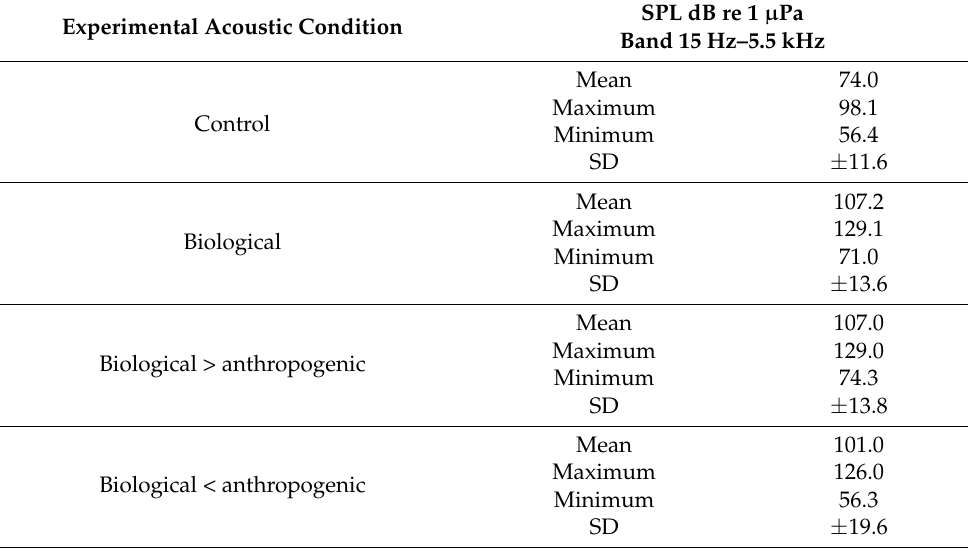
Table 2. Mean, maximum, minimum, and standard deviation of experimental conditions sound pressure levels (SPLs) (dB re 1 µ Pa) recorded inside the experimental